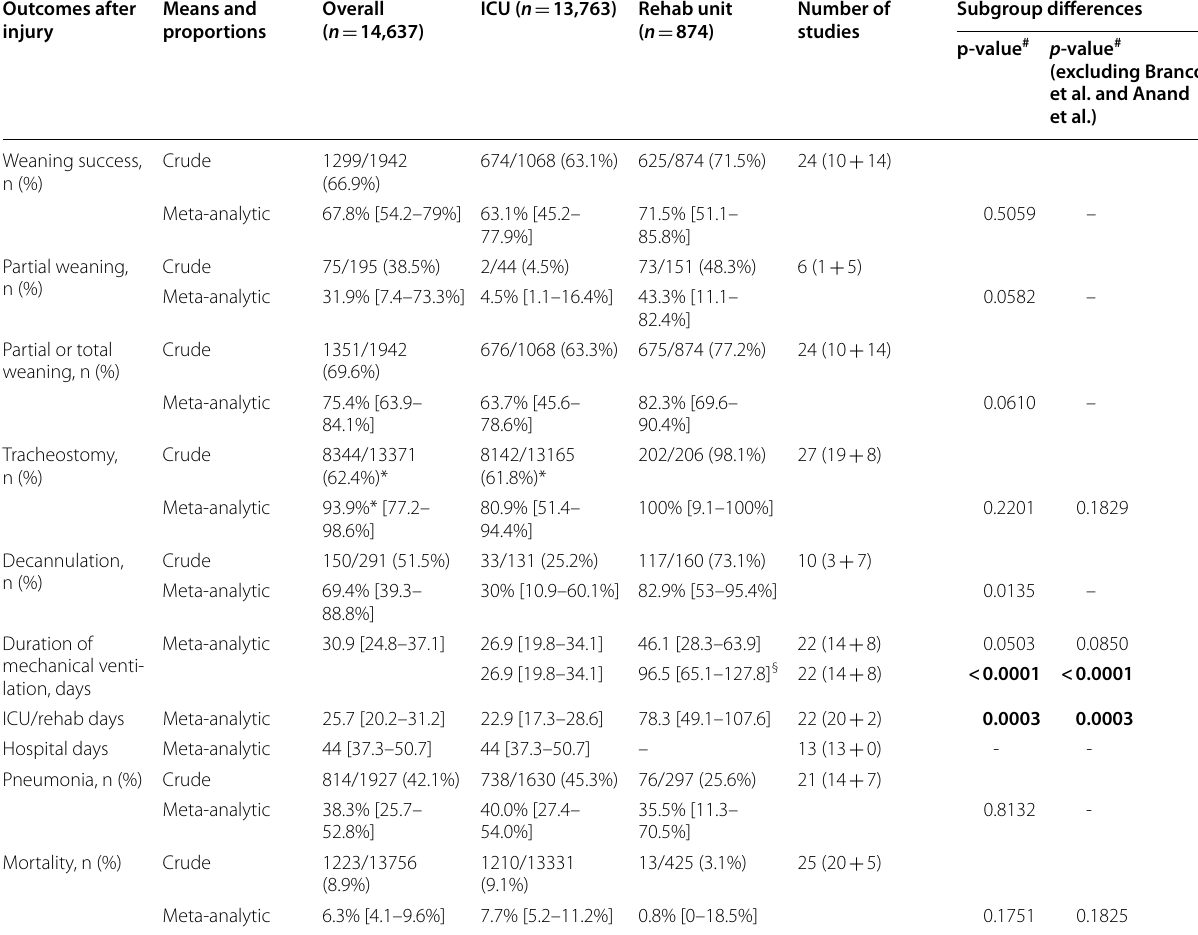
Table 1 Main outcomes after